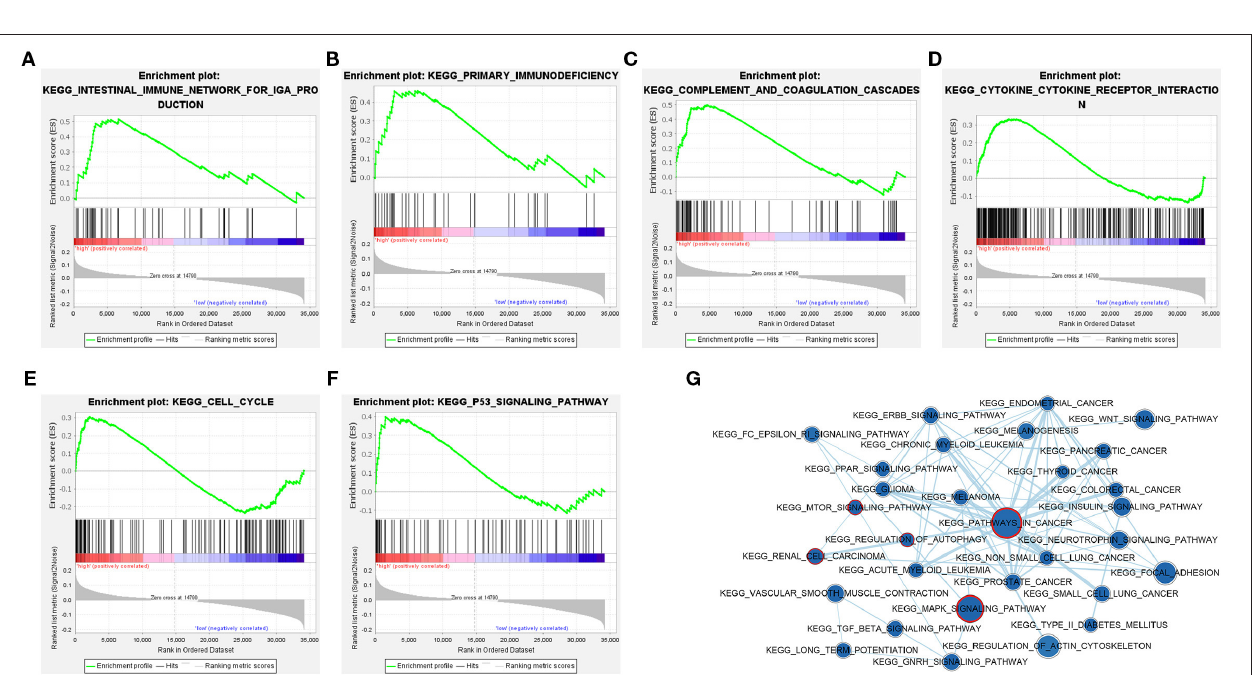
FIGURE 9 | clinical phenotype. (I) Multivariate Cox regression analysis of correlations between the risk score for OS and clinical phenotype. (J) The distribution of risk score between distant metastasis patients (M1) and non-distant metastasis patients (M0). The value of p < 0.05 was considered statistically significant. LASSO, least absolute shrinkage and selection operator; ROC, receiver operating characteristic; OS, overall survival; ccRCC, clear cell renal cell carcinoma.